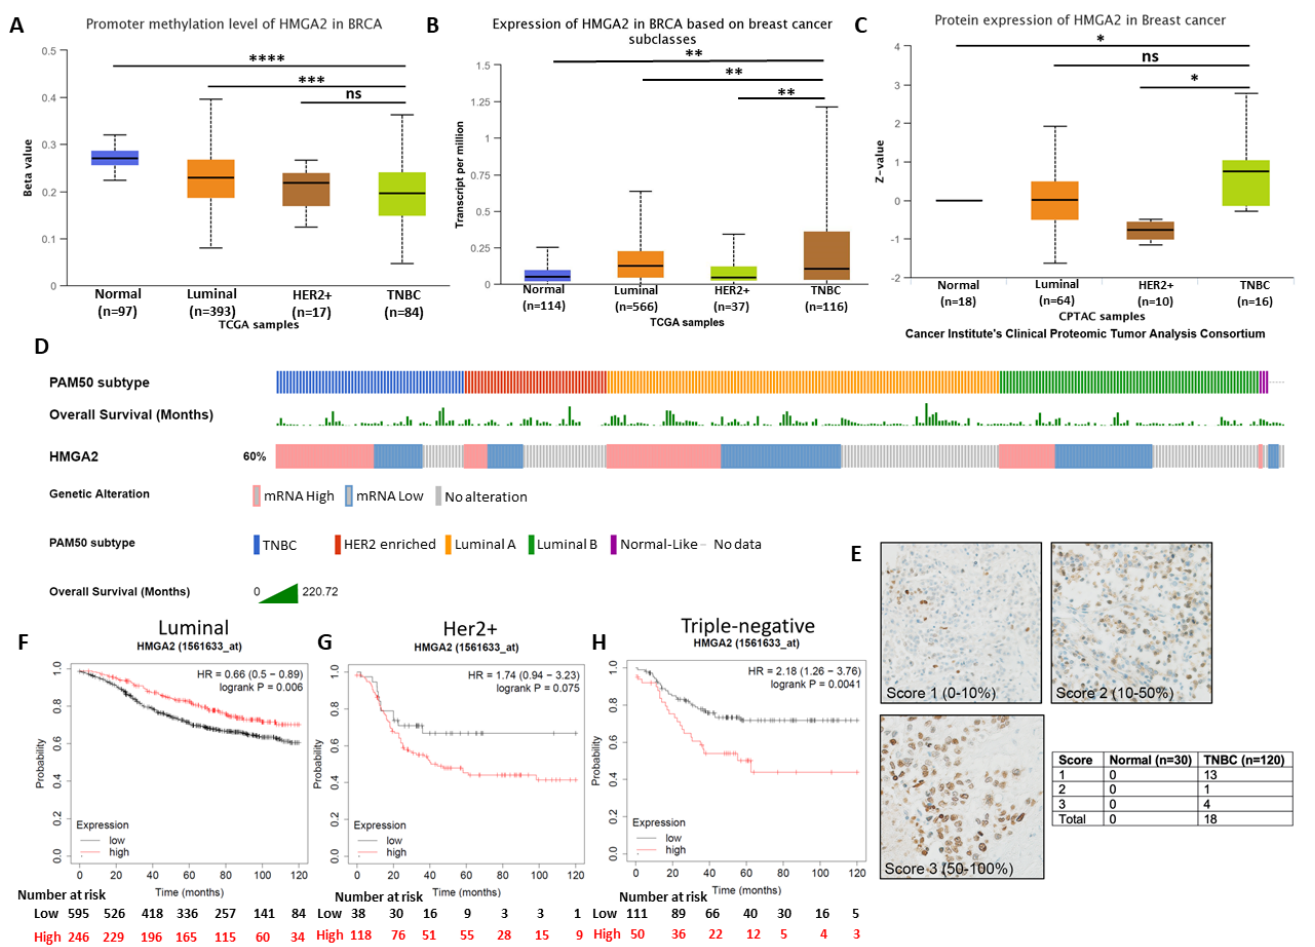
Figure 1. HMGA2 overexpression reduced the survival rate in TNBC patients. ( A ) HMGA2 promoter methylation was decreased in TNBC subclasses compared to luminal breast cancer and normal tissues. HMGA2 ( B ) mRNA and ( C ) protein expression was increased in TNBC compared to other breast cancer subclasses from TCGA and the Cancer Institute’s Clinical Proteomic Tumor Consortium (CPTAC) samples, respectively. HMGA2 overexpression was shown in more than 50% TNBC patients and overall survival of each patient presented as separate row above the HMGA2 expression ( D ). Representative immunohistochemistry staining for HMGA2 in normal ( n = 30) and TNBC tissues ( n = 120) ( E ). Kaplan Meier survival analysis compares breast cancer patients with luminal ( F ), HER2+ ( G ) and TNBC ( H ) subtypes exhibiting HMGA2 low (black line) versus HMGA2 high (red line) expression. The analysis showed that low HMGA2 in patients with luminal breast cancer was associated with poor overall survival, as was low HMGA2 in patients with HER2+ breast cancer and TNBC. * p < 0.05, ** p < 0.01, *** p < 0.001, and **** p < 0.0001.